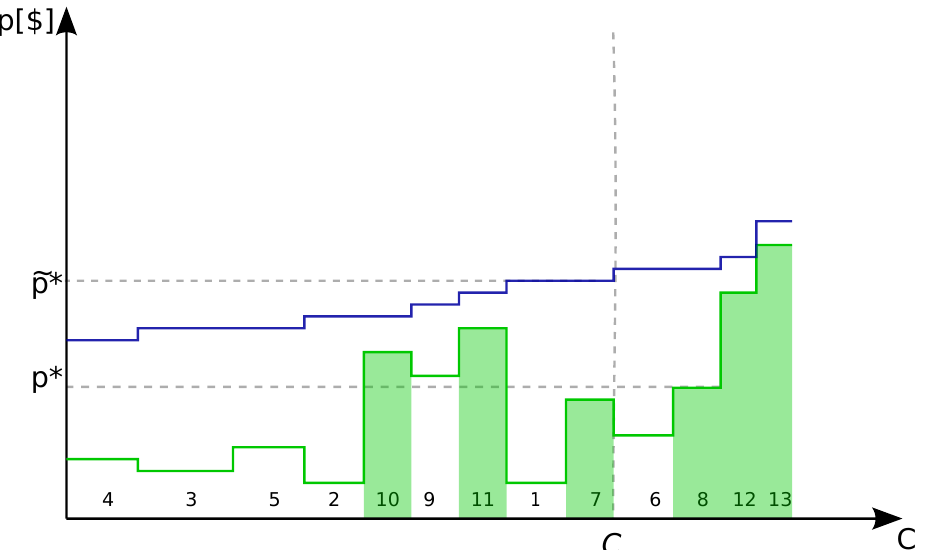
Figure 4. Merit order for the same sample of 13 exemplary power plants as depicted in Figure 3 again identifiable by the respective number n = 1, . . . ,13 under consideration of capacity bids (lower graph) and respective adjusted price markups (upper graph) for power plants ordered by increasing total costs (step